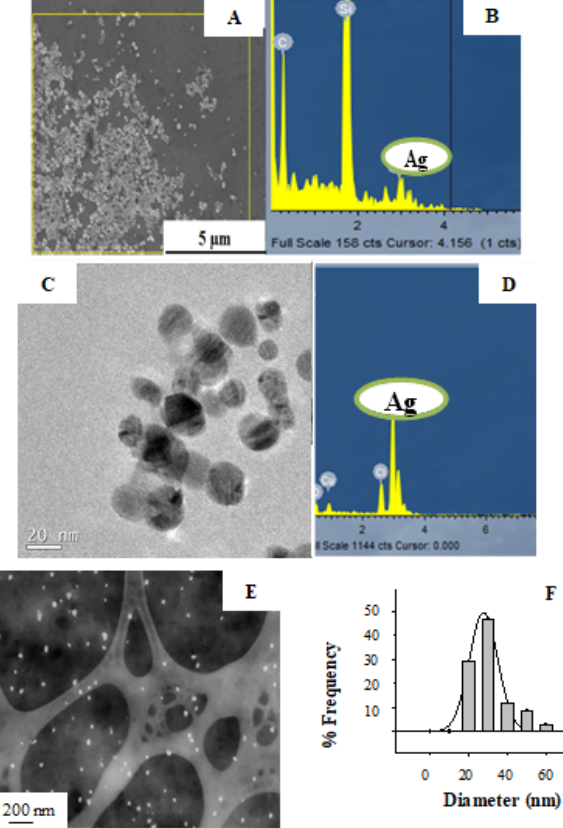
Figure 4. Electron Microscopy micrographs for Ag-NPs synthesized at pH 4 using the GS extract as reducing agent. SEM micrograph ( A ), corresponding EDX spectra ( B ) and TEM micrograph ( C ) with corresponding EDX spectra ( D ) showing the presence of silver. STEM image of Ag-NPs ( E ) with size distribution histogram ( F ).